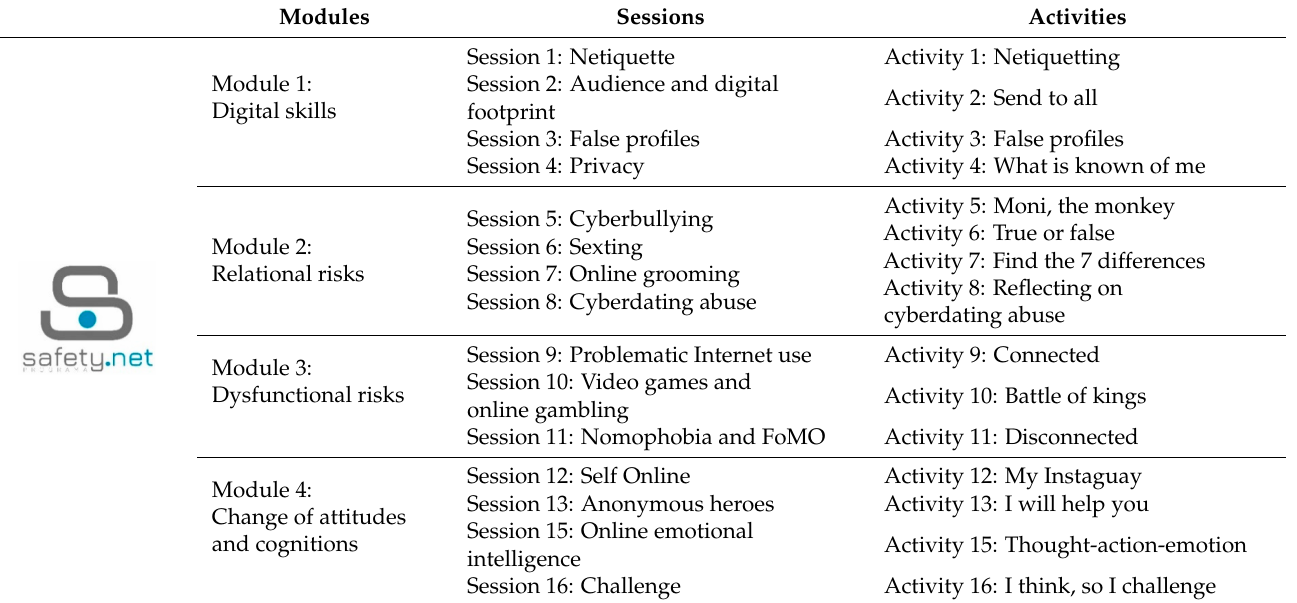
Table 2. Structure of sessions and modules of the Safety.net